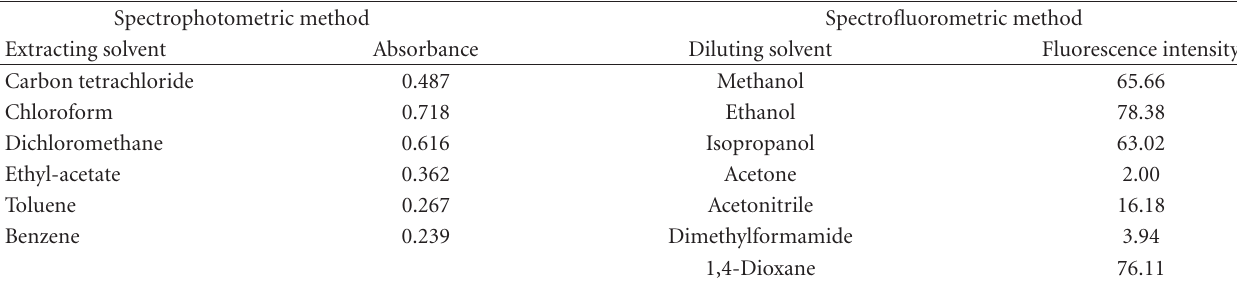
Table 1: E ff ect of diluting and extracting solvents on the intensity of the reaction product of AMD with NQS (0.06%, w/v). Values for all solvents are mean of three determinations; the RSDs for the readings were < 3.